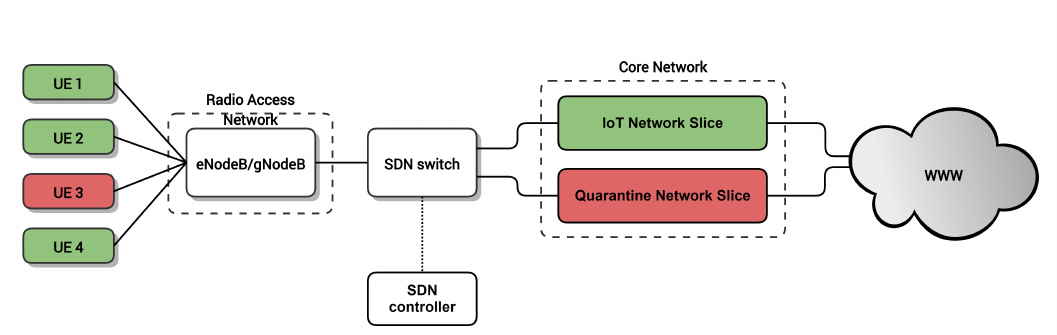
Figure 1. Proposed quarantine